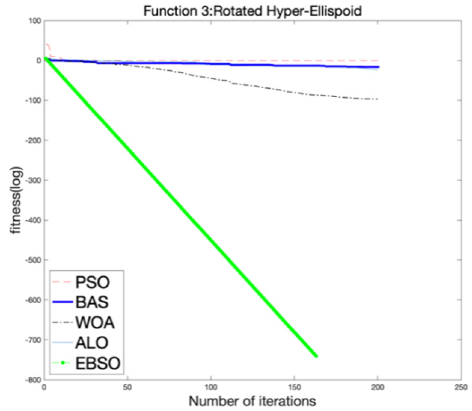
Figure 9. Iterative convergence graph .